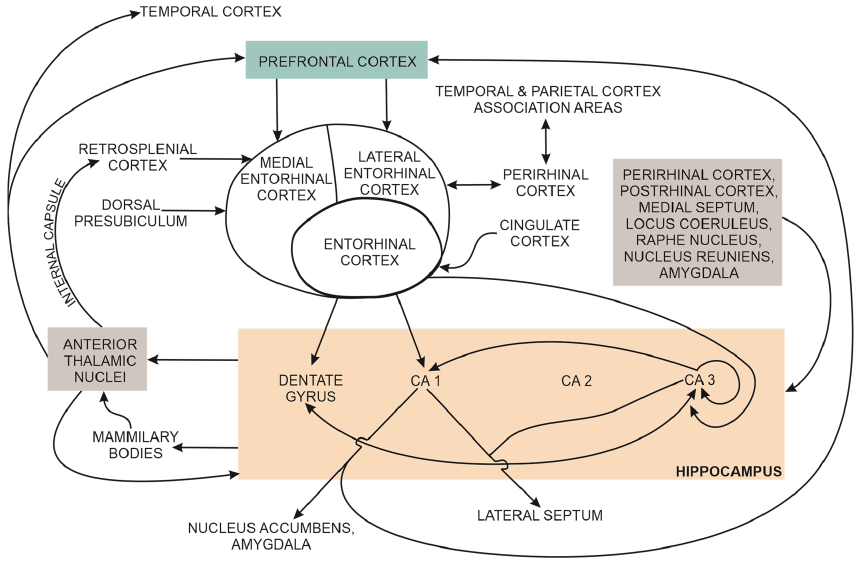
Figure 5. A simplified summary of hippocampal connections in mammals. The dentate gyrus and Figure 5. A simpli fi ed summary of hippocampal connections in mammals. The dentate gyrus and sub fi elds CA1 to CA3 are functionally and anatomically distinct hippocampal subunits. subfields CA1 to CA3 are functionally and anatomically distinct hippocampal